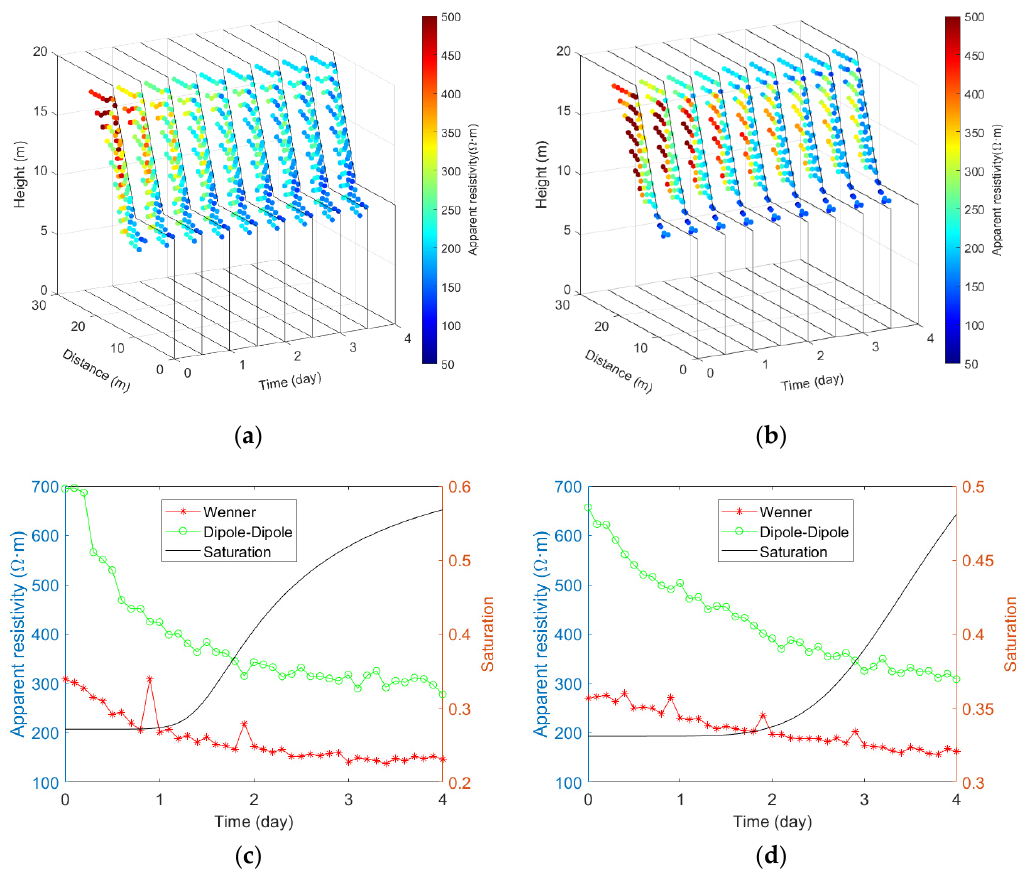
Figure 10. Apparent resistivity response of WECC for Wenner and Dipole-Dipole arrays with the combination of multiple conditions: ( a ) Wenner array; ( b ) Dipole-Dipole array. ( c ) Apparent resistivity and saturation at point A with time. ( d ) Apparent resistivity and saturation at point B with time.